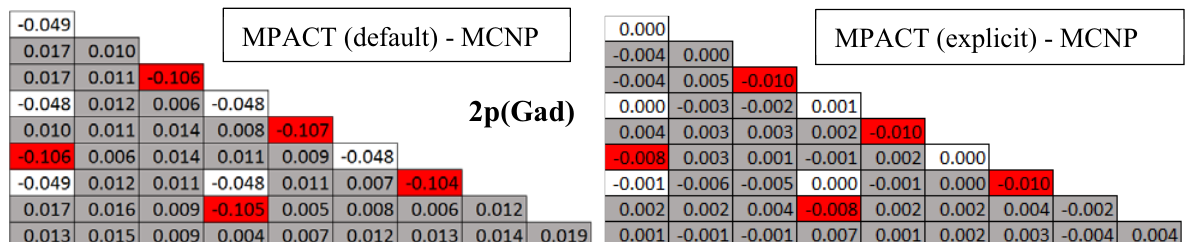
Figure 1. Comparison of energy deposition between MPACT and MCNP. Maximum standard deviation of MCNP results: 0.0017.